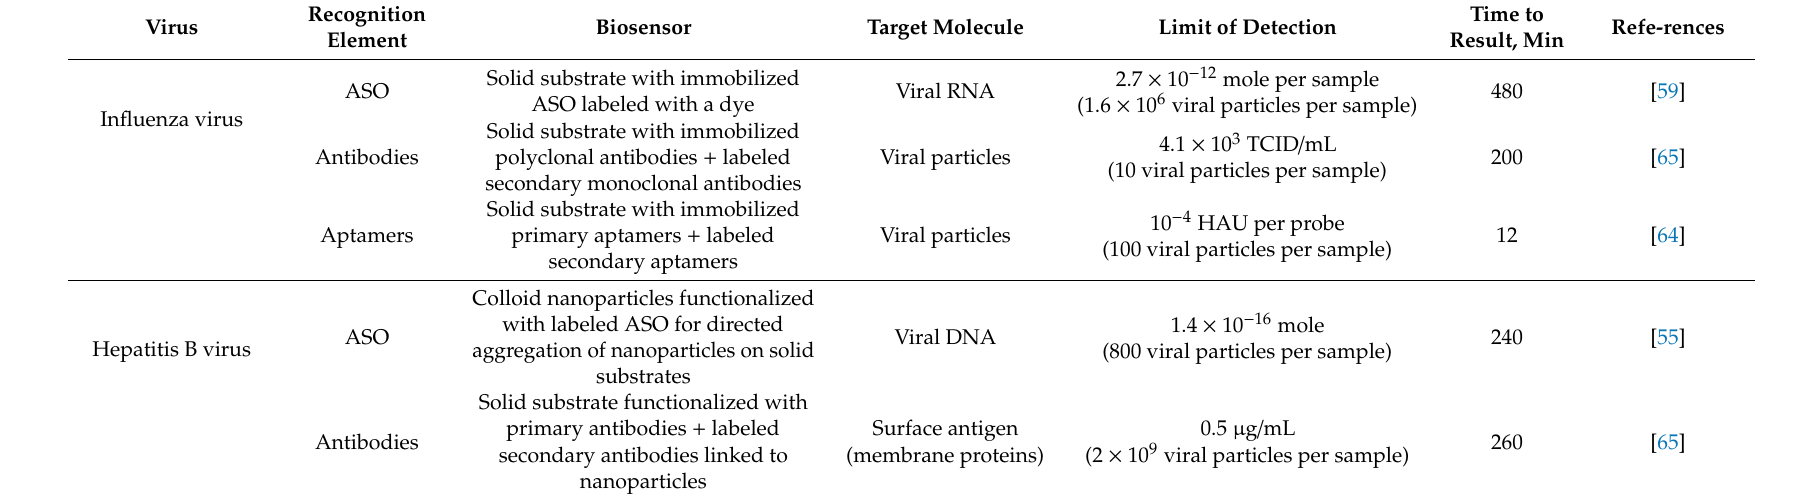
Table 1. Comparison between the characteristics of di ff erent types of biosensors in the identification of the same type of virus. The indirect SERS-based assays are summarized based on the recognition element: ASO, aptamer or